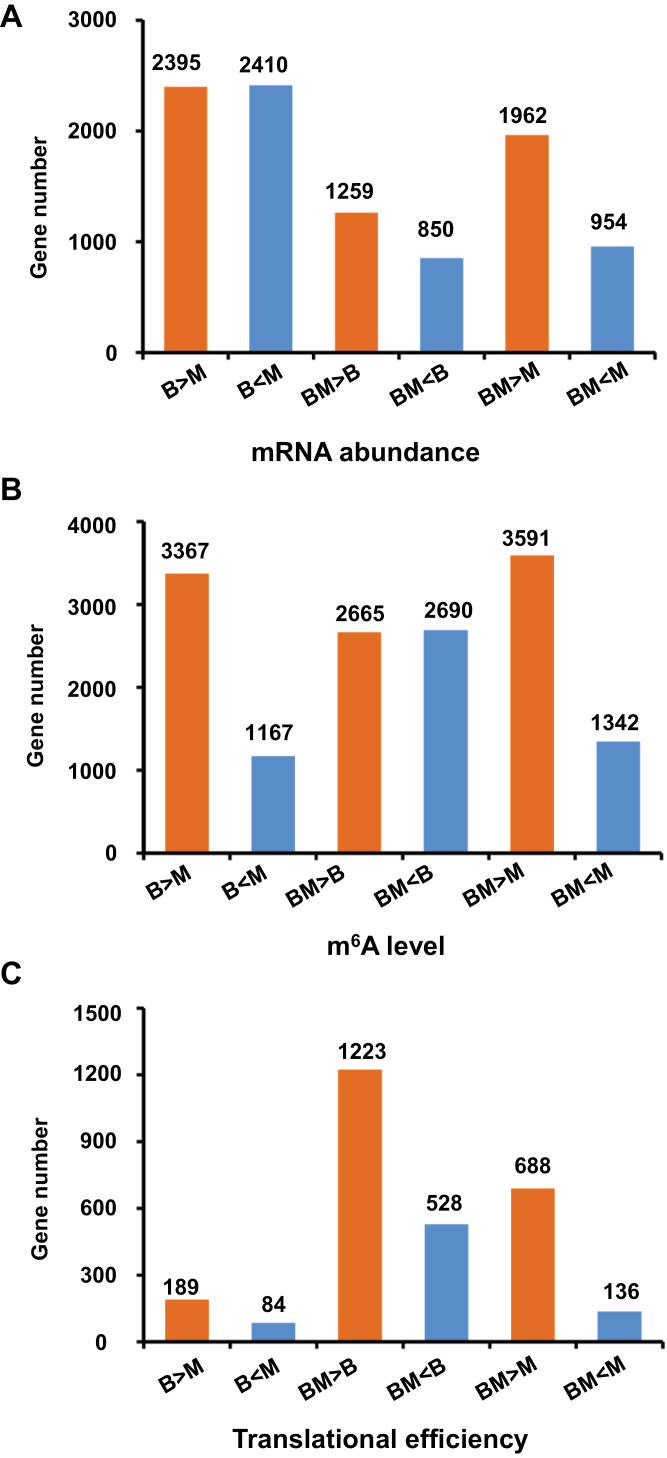
Differential genes among hybrid and parents at the levels of mRNA abundance, m6A modification and translational efficiency. (A–C) Differential genes at the mRNA abundance level (A), m6A modification (B), and translational efficiency (C) were identified on the basis of six pairwise comparisons among the hybrid and parents. The number of differential genes, which were designated with false discovery rate (FDR) <0.01 and fold change ≥1.5, are shown above each bar. B, B73; M, Mo17; BM, B73×Mo17.